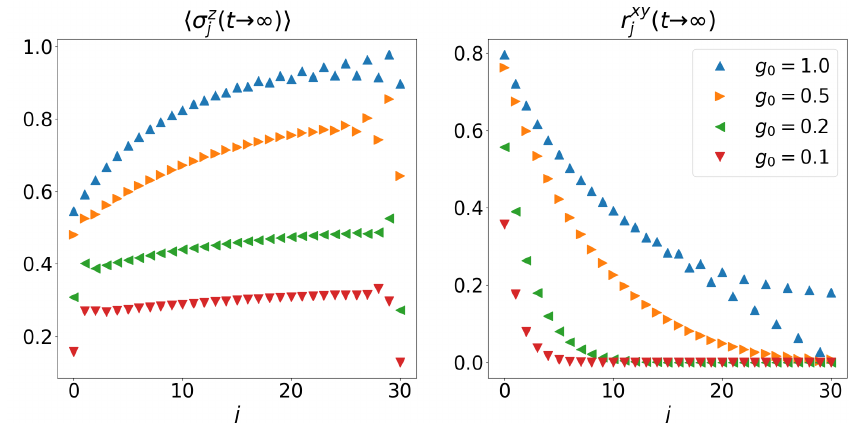
Figure 19: The expectation value of each qubit’s Pauli components in the steady state, for Z (left) and X , Y (right), given as the length of the Bloch vector component in (cid:112) 〈 σ x 〉 2 + 〈 σ y 〉 2 , for 31 qubits in a 1D chain, with varying values of x y plane, r x y ≡ = 0.1 and g = 1, with the other parameters as in Fig. 4. The ending g , between g 0 0 0 time of each simulation obeys t ≫ 1 / g , with the steady state approached faster for 0 stronger decay rates. The competition of the energy relaxation with the excitation dynamics leads to the shown patterns – see the text for a detailed discussion.